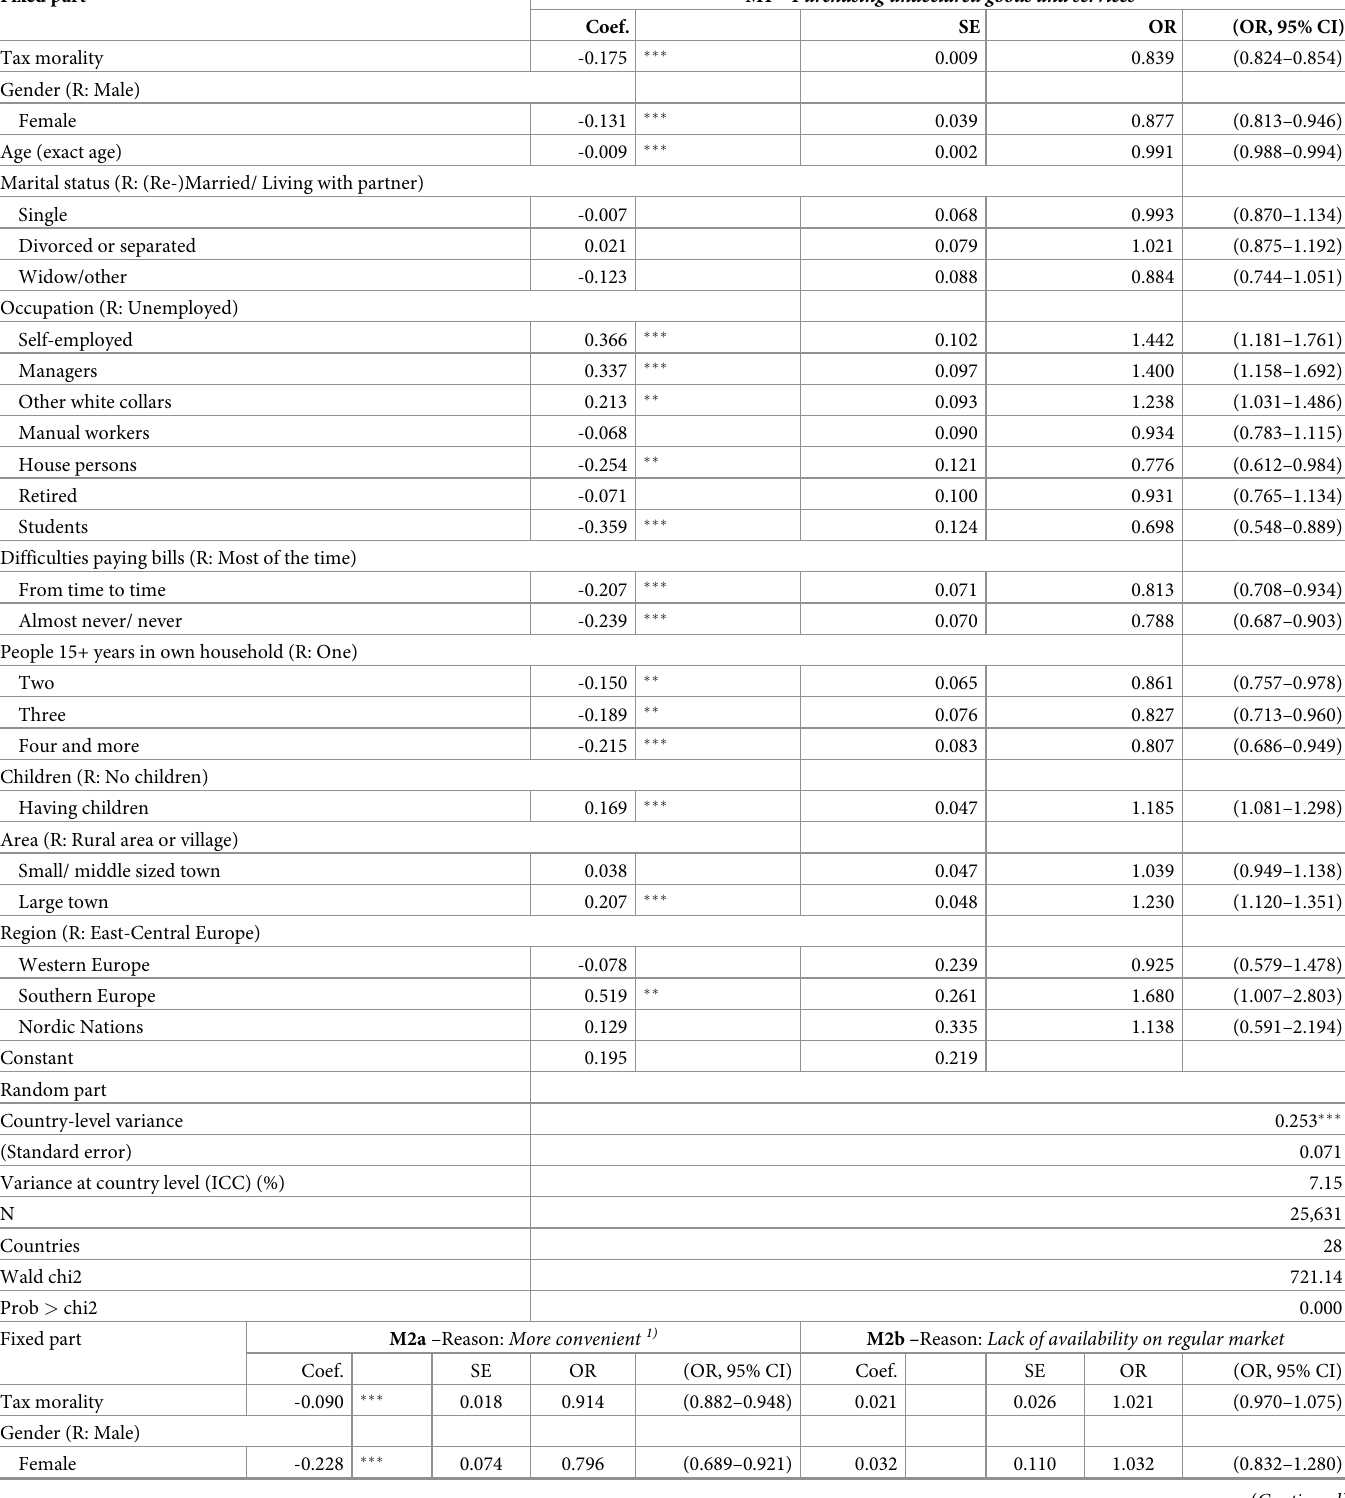
Table 4. Multilevel mixed-effects logistic regression of the probability to purchase from the informal economy in the EU-27 and the United Kingdom. Fixed